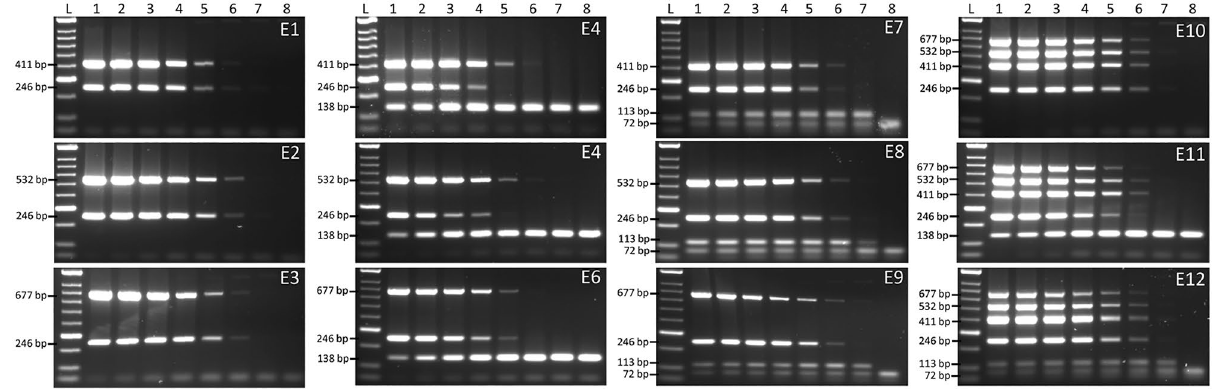
Figure 2. Comparative sensitivity assays to predict the detection limit of Rathayibacter toxicus using multiplex endpoint PCR with and without internal controls. Lane 1–7 are tenfold serial dilutions of genomic DNA from 1 ng to 1 fg; lane 8 is non-template control (NTC; water). Qiagen multiplex kit was used for these sensitivity assays. E1. DNA from population RT-I only + No AIC; E2. DNA from population RT-II only + No AIC; E3. DNA from population RT-III only + No AIC; E4. DNA from population RT-I only + AIC-1; E5. DNA from population RT-II only + AIC-1; E6. DNA from population RT-III only + AIC-1; E7. DNA from population RT-I only + AIC-2 & HIC; E8. DNA from population RT-II only + AIC-2 & HIC; E9. DNA from population RT-III only + AIC-2 & HIC; E10. DNA from all three populations + No AIC; E11. DNA from all three populations + AIC-1; E12. DNA from all three populations + AIC-2 &